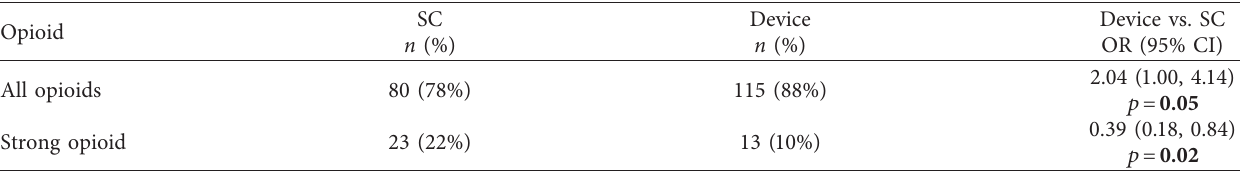
Table 7: Opioid prescription on discharge in standard care (SC) group and both device groups. SC Device Device vs. Opioid